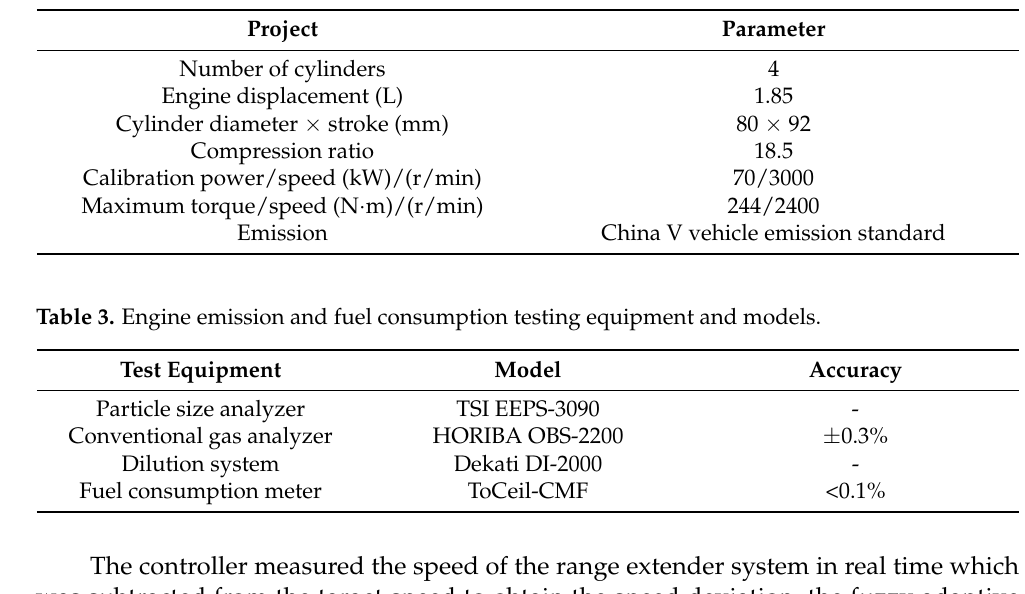
Figure 2. Bench test system. Table 2. Main parameters of the engine.